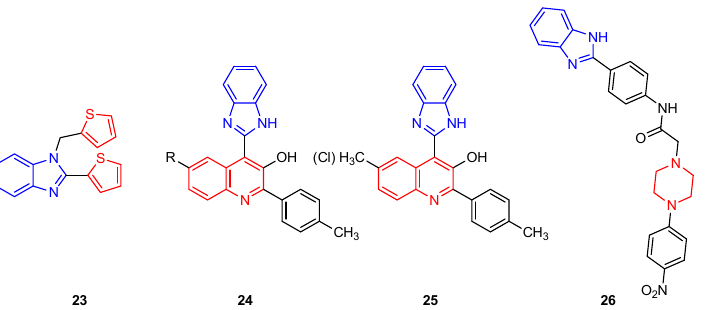
Figure 17. Thiophenyl, quinolin-2-ols, benzohydrazone, thiadiazol-5-yl, piperazine–benzimidazole derivative structures.